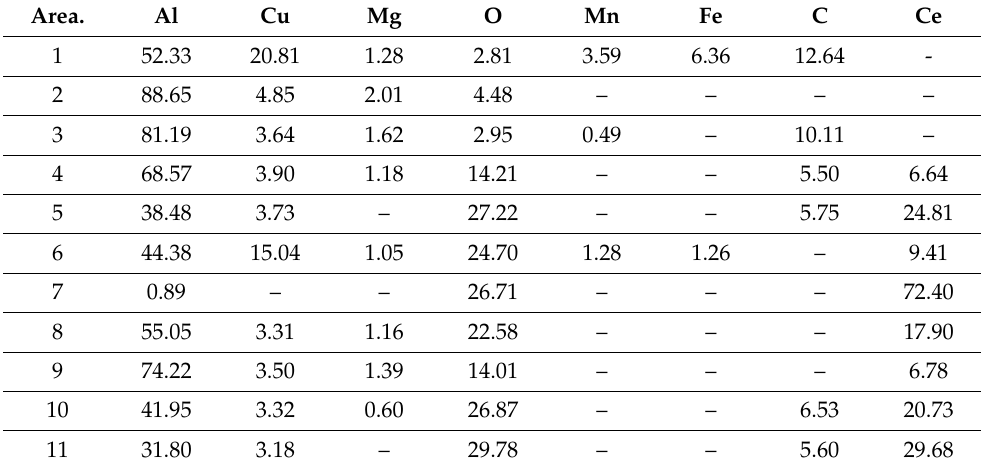
Table 2. Semiquantitative EDX analyses (wt. %) in areas marked in Figure 1.